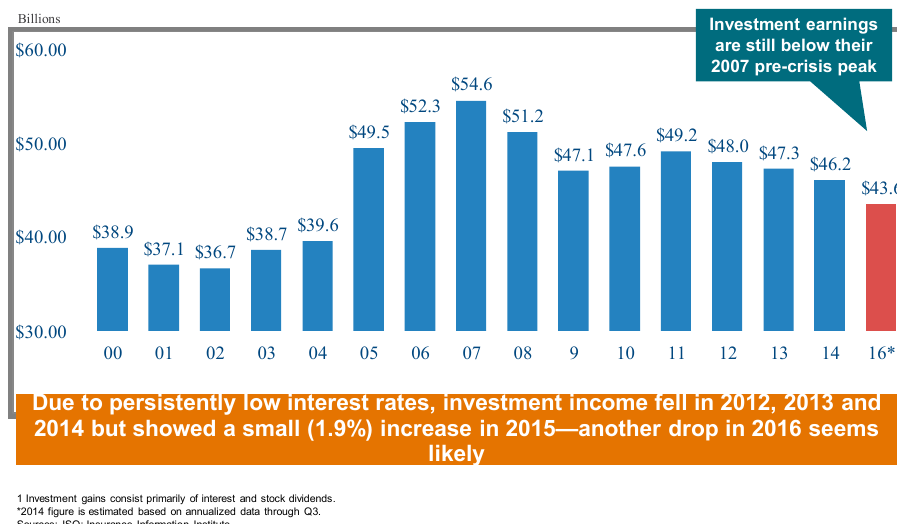
Figure 5. P / C Insurance Industry Investment